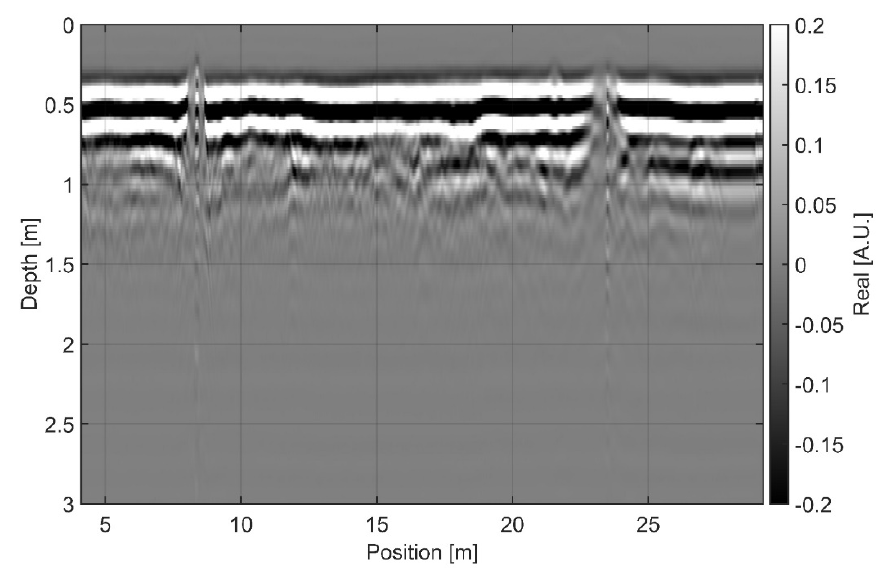
Figure 10. GPR signal synchronized and stacked with position retrieved by IBIS.